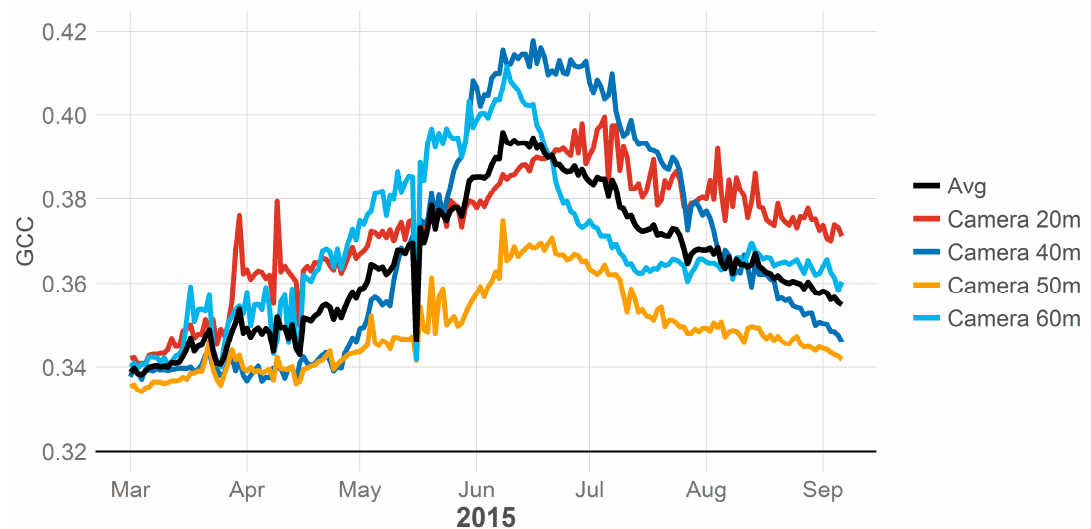
Figure 3. The daily GCC values from the four individual cameras and their average at rangeland site 54-8 in the Idaho study area.